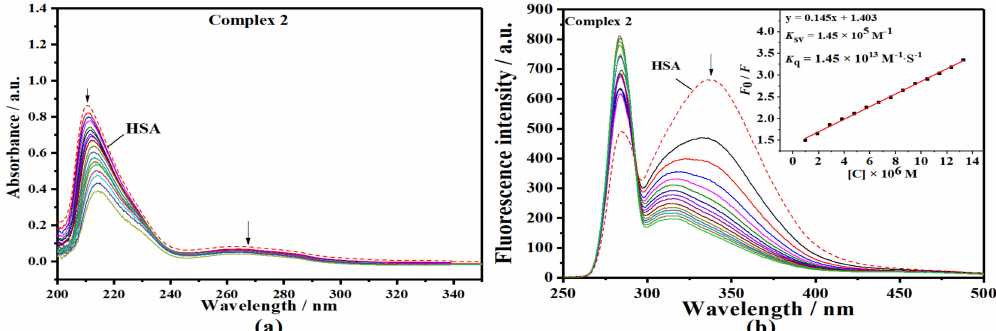
Figure 7. HSA electronic absorption spectra with and without complex 2 ( a ). HSA platform emission spectra with and without complex 2 ( b ). Inset: F 0 / F vs. [C] plot. Arrows illustrate the changes in intensity with increasing quantity of the